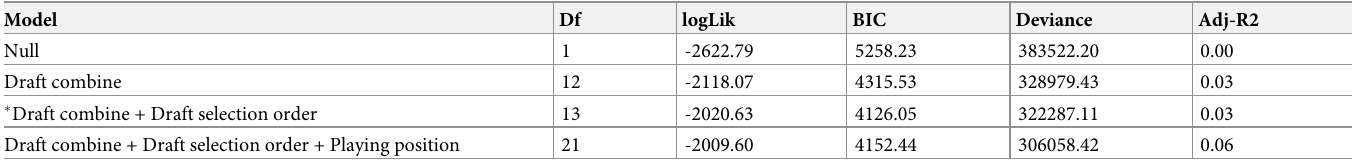
Table 4. Summary of model outputs for AFL Player Ranking.